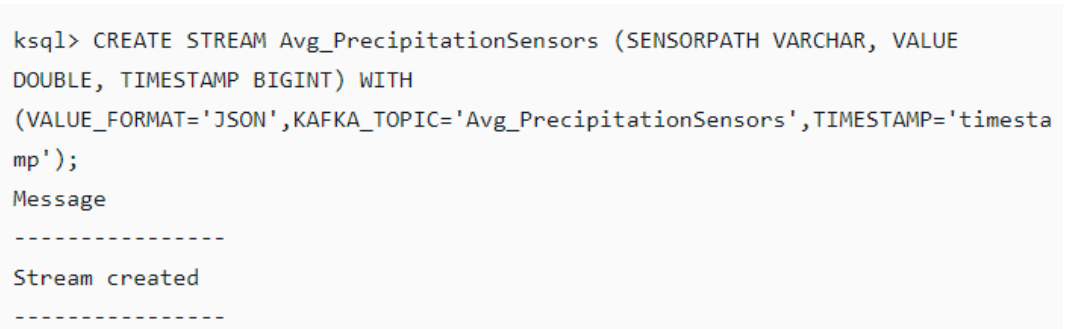
Figure 14. Creating topic in the Kafka broker through the